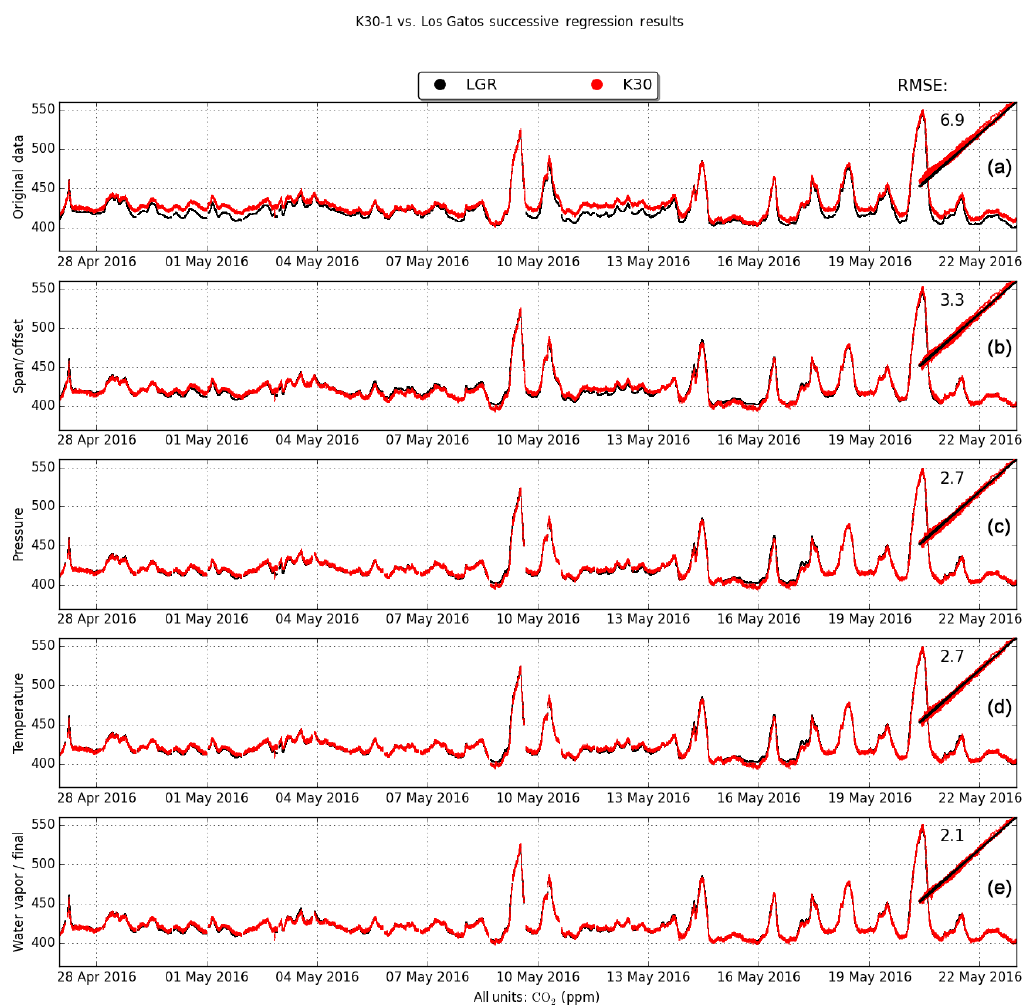
Figure 6. A continuous time series of 1min averages as well as scatter plots for K30-1 compared to the LGR instrument during each step of the successive regression described in Sect. 5.1. Cumulative, in order from top to bottom: the original dataset, after correcting for span and offset, after correcting for pressure, after correcting for temperature and, finally, after correcting for water vapor. The root mean square error (RMSE) of the K30 data compared to the LGR at each step is annotated to the upper left of the scatter plot. This regression contains all data points observed in the evaluation period. Table 1. Root mean square error inppm between the CEAS LGR and each K30 NDIR sensor’s 1min averaged data for the original dataset before correction, at each step of the successive regression correction (correcting for (1) zero/span, (2) atmospheric pressure, (3) temperature and (4) water vapor mixing ratio) and after the multivariate regression correction. Each value shown is for a regression calculated using data from the entire evaluation